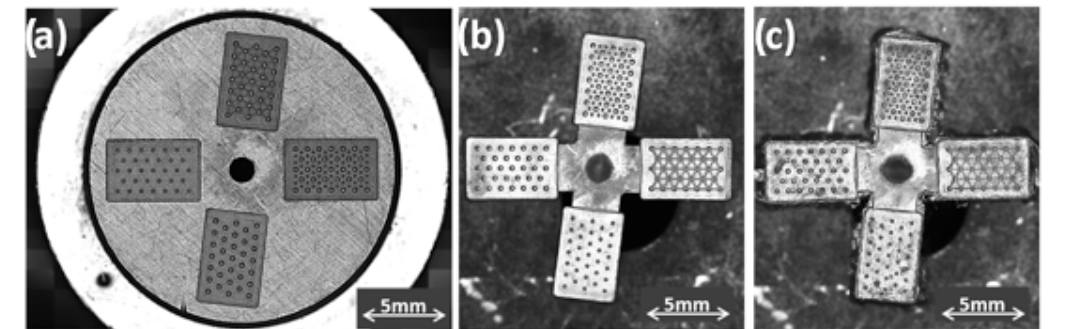
Figure 10. Mold cavities ( a ) and molded samples ( b ) HDPE, ( c ) UHMWPE.